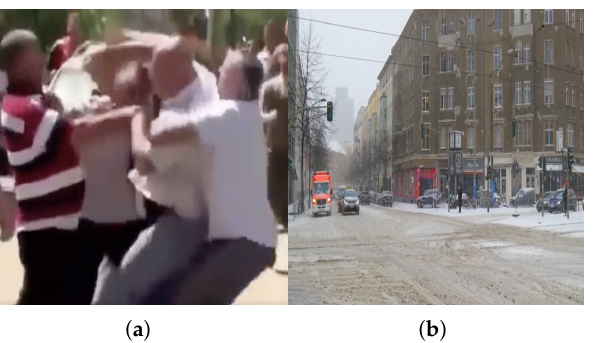
Figure 2. Screenshots of videos in the dataset: ( a ) features violence, and ( b ) features day-to-day activities in a city